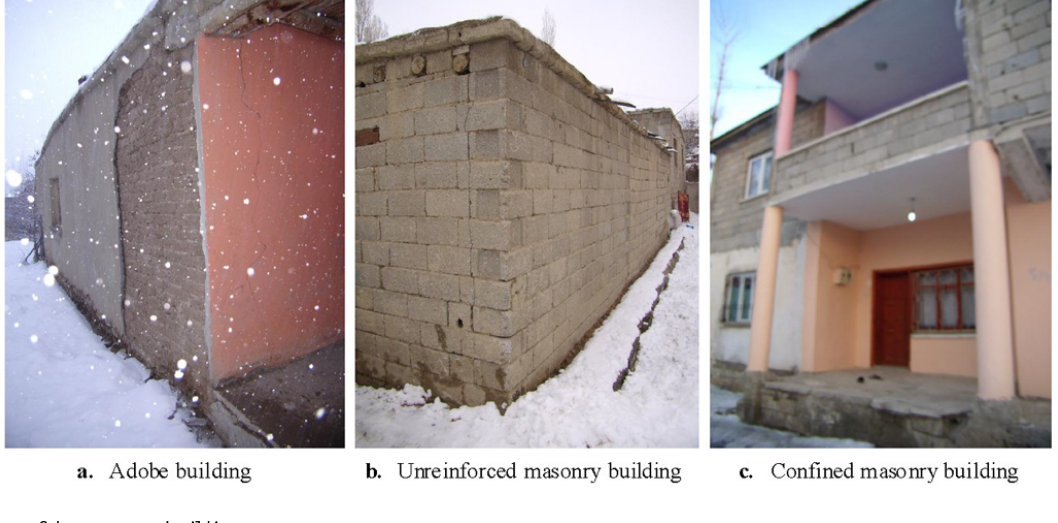
Fig. 9. Types of the masonry buildings.